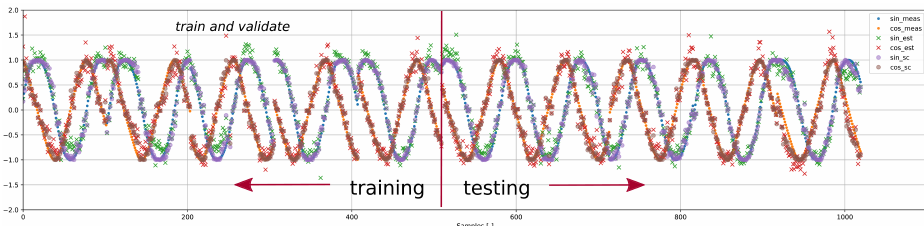
Figure 8. Division of data into training, validation, and